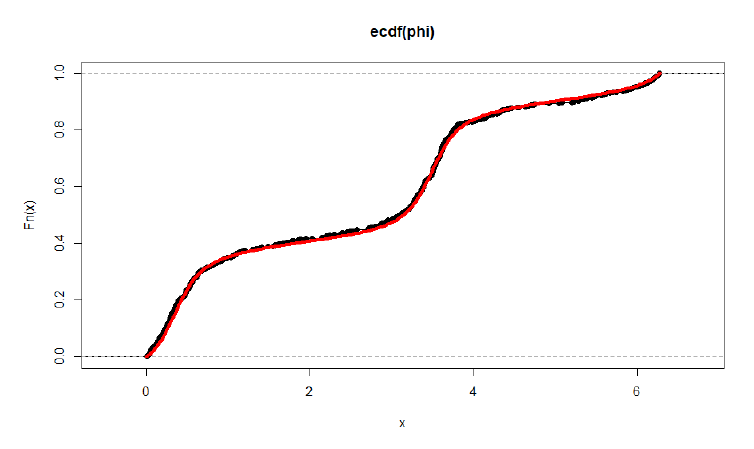
Figure 14: empirical distribution function of Ψ (black) and that of the model